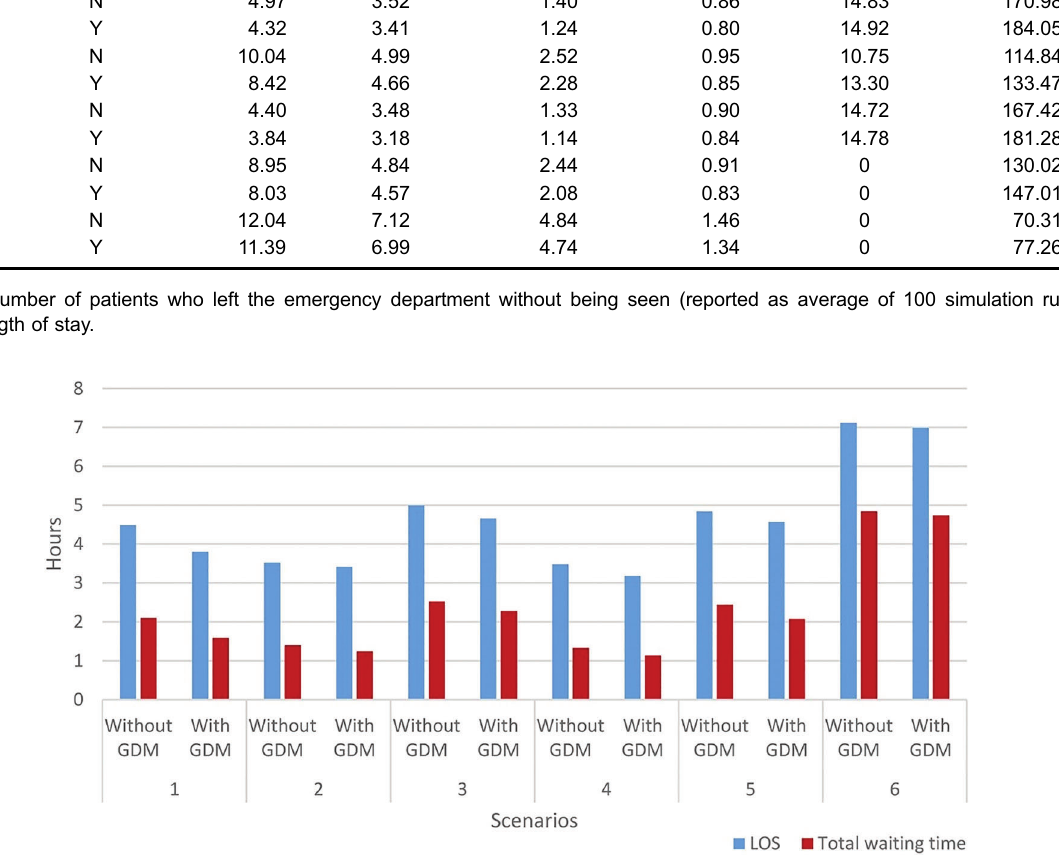
Figure 6. Comparison of average length of stay (LOS) and average total waiting time before and after applying group decision-making (GDM) in different scenarios.